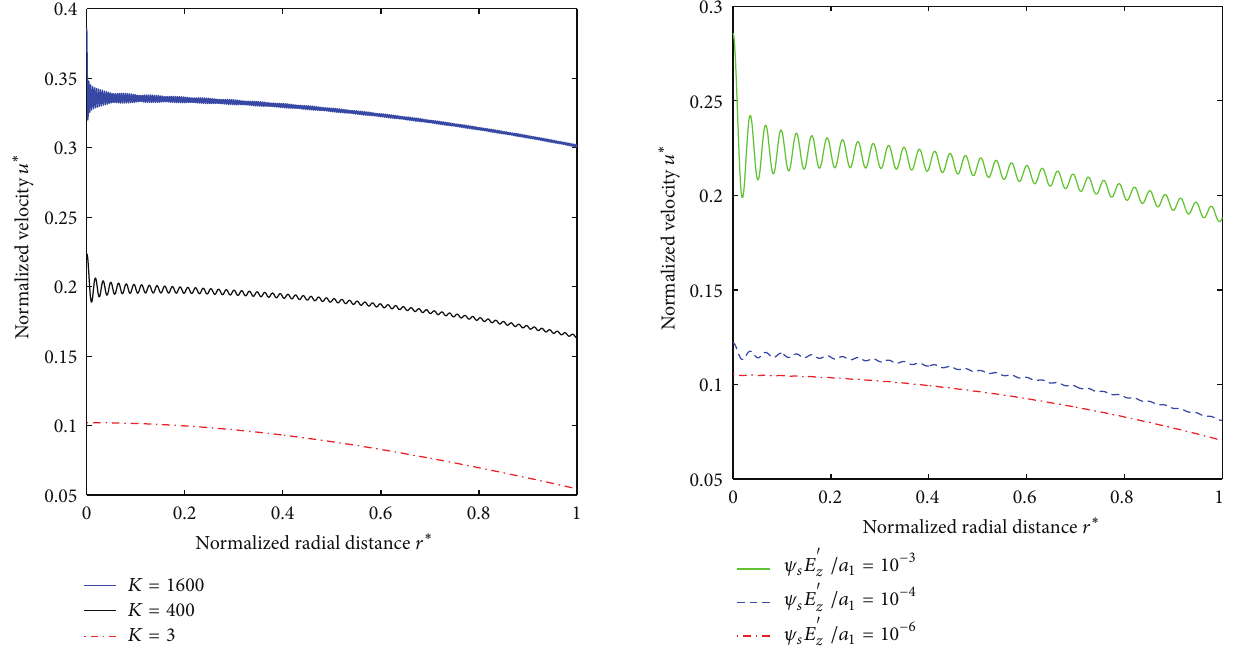
Figure 7: Influence of magnitude of electric field on the velocity profile at a typical time 𝑡 ∗ = 𝜃/2𝜋 , 𝑙 ∗ = 0.5 , 𝐾 = 200